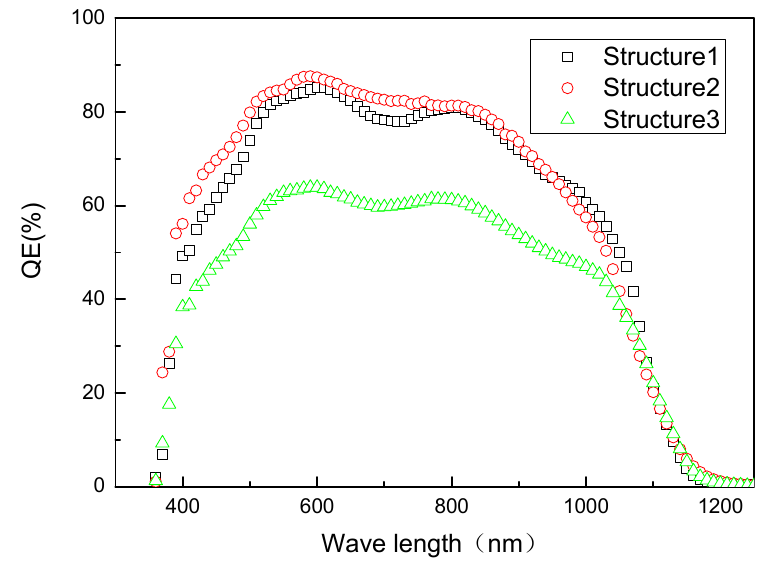
Figure 8. External quantum efficiencies of the solar-cell devices.